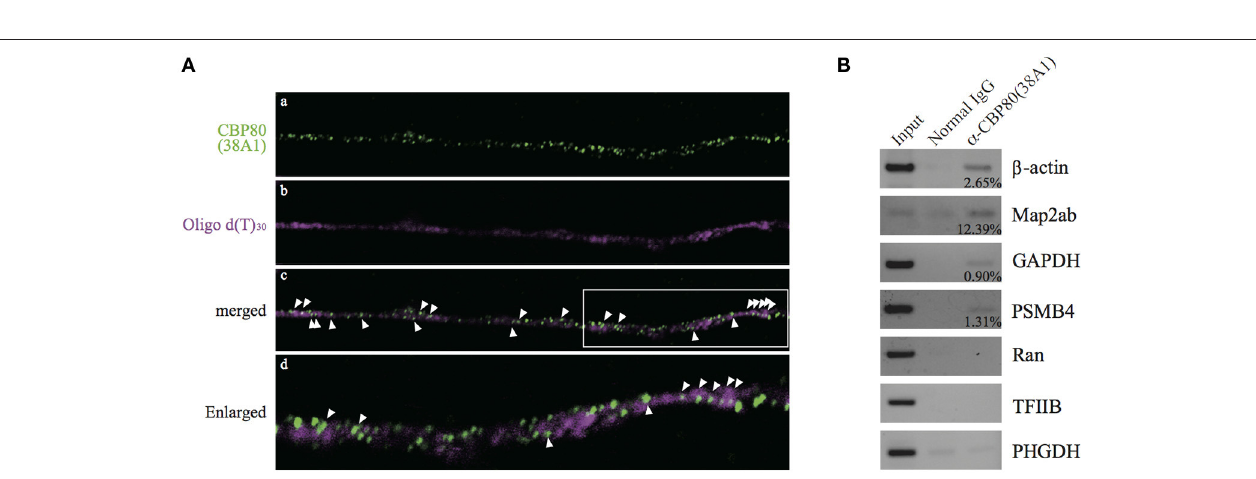
FIGURE 2 | CBP80-positive puncta contain poly(A) RNA. (A) Microimages of differentiated SH-SY5Y cells stained with (a) 38A1 antibody against CBP80 (green) and (b) oligo d(T) 30 -fluorescein (magenta). The merged image is shown in (c) . Arrowheads point to fluorescent puncta that contain both CBP80 and poly(A). (d) Enlarged image of white box in (c) . (B) RT-PCR analyses of the mRNAs from the co-immunoprecipitation experiments. Input lanes contain 10% of total amount of RNA recovered from the cytoplasmic fractions used for RT-PCR. Normal mouse IgG was used as a control and anti-CBP80 antibody (38A1) was utilized for immunoprecipitation of RNP. Input lanes contain 10% of total input used for immunoprecipitation. The percentages of immunoprecipitated mRNAs by anti-CBP80 (38A1) are indicated in the